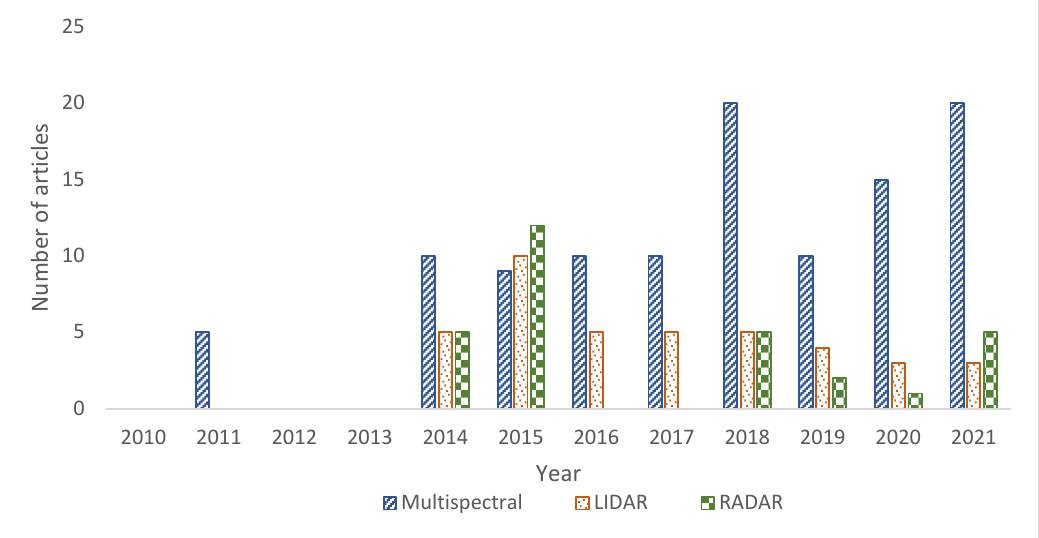
Figure 3. Year-wise distribution of articles from each category.